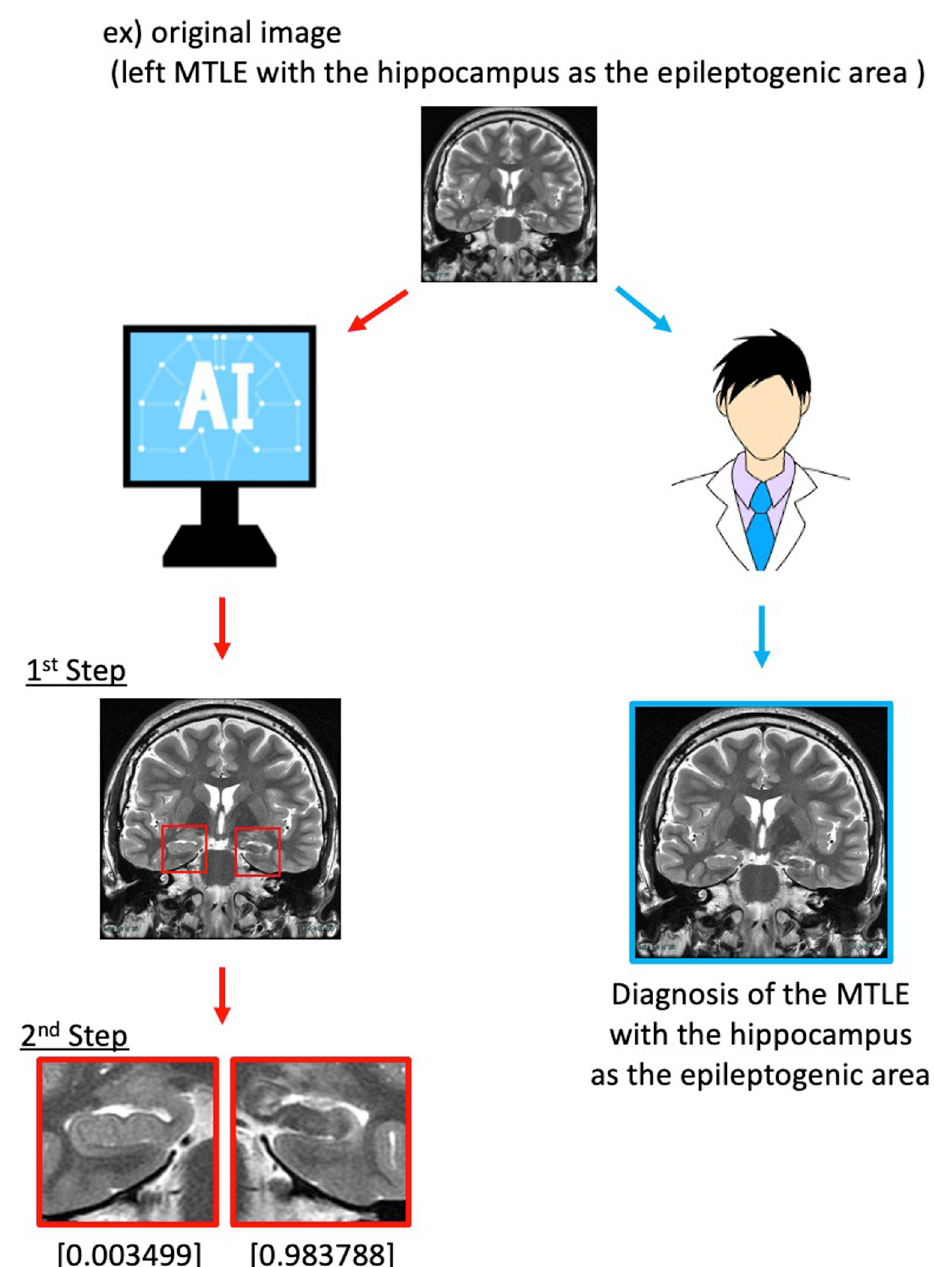
Fig 3. Scheme of hippocampal detection and prediction of MTLE with the hippocampus as the epileptogenic area. In the AI program, the first step is to automatically detect the hippocampus on conventional T2WI and FLAIR coronal sections. The second step is to diagnose MTLE with the hippocampus as the epileptogenic area and predict the probability of the disease. Six board-certified neurosurgeons diagnosed MTLE with the hippocampus as the epileptogenic area using an original image of one